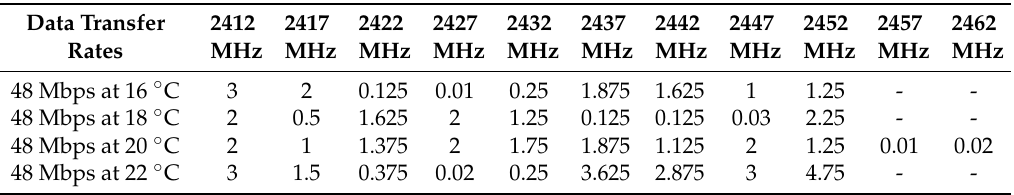
Table 18. Calculation of residuals for OFDM at 48 Mbps.